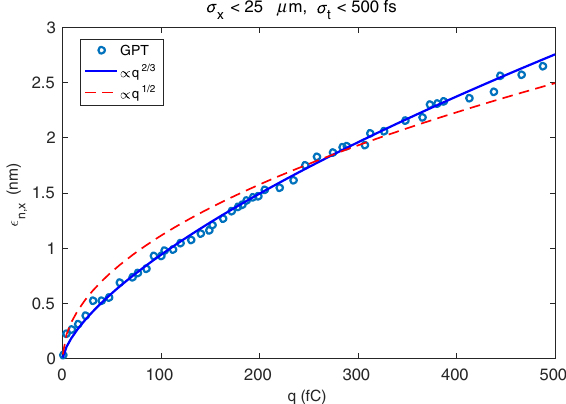
FIG. 2. Optimal emittance as a function of bunch charge at the sample for a final beam size of σ x ≤ 25 , σ ≤ 500